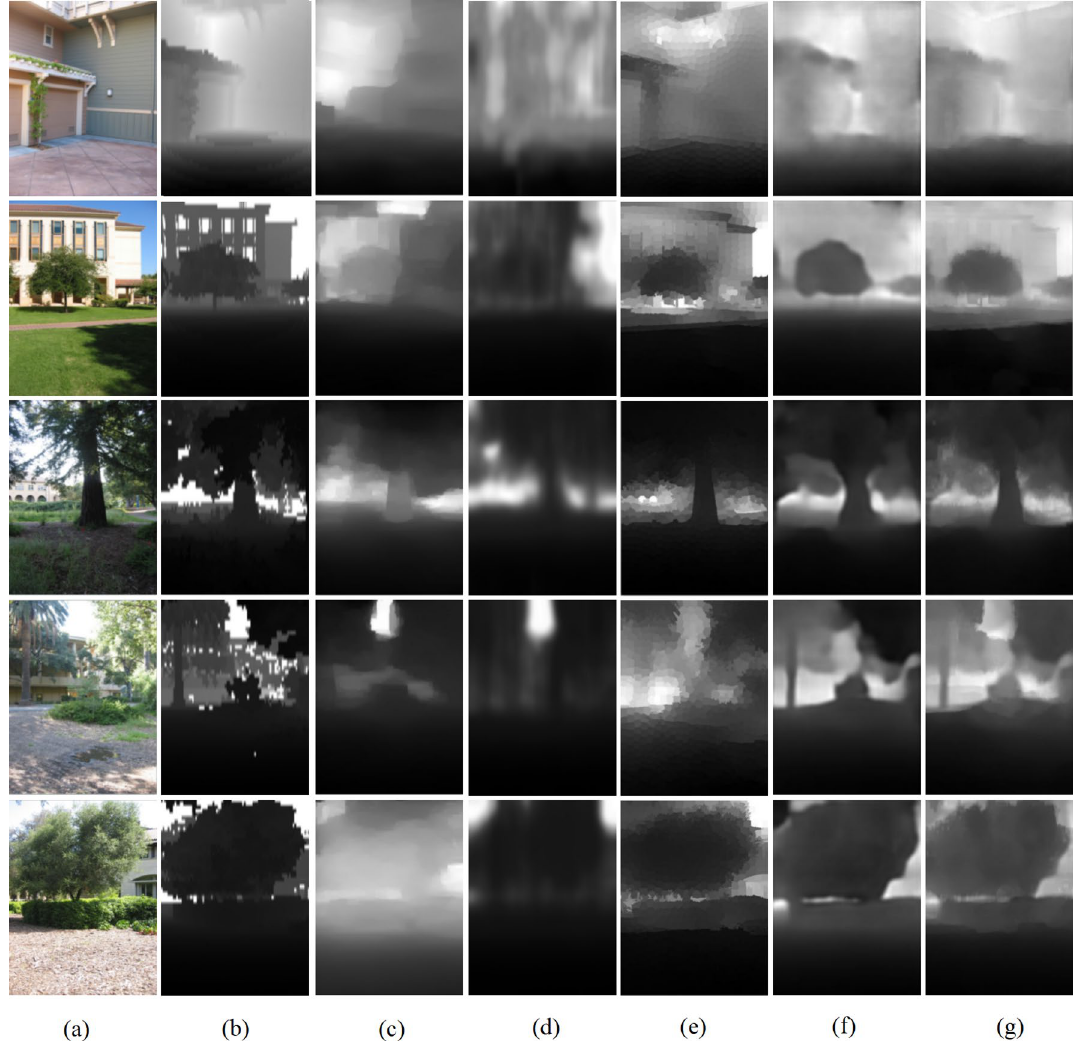
Fig. 3 Experimental results on Make3D dataset a the input image b the ground truth c DT [11] d SF [19] e DCNF [22] f FCRN [23] and g the proposed